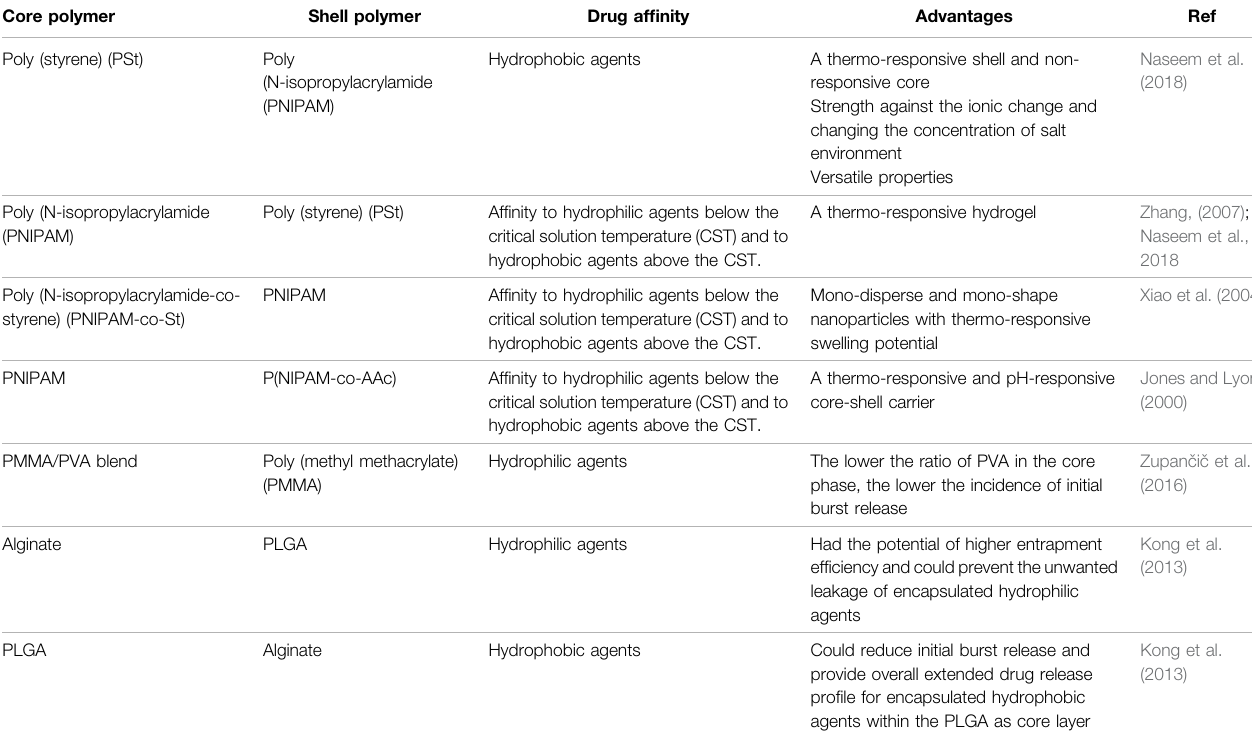
TABLE 3 | Different polymers which were used in the fabrication of core-shell polymeric carriers as novel drug delivery